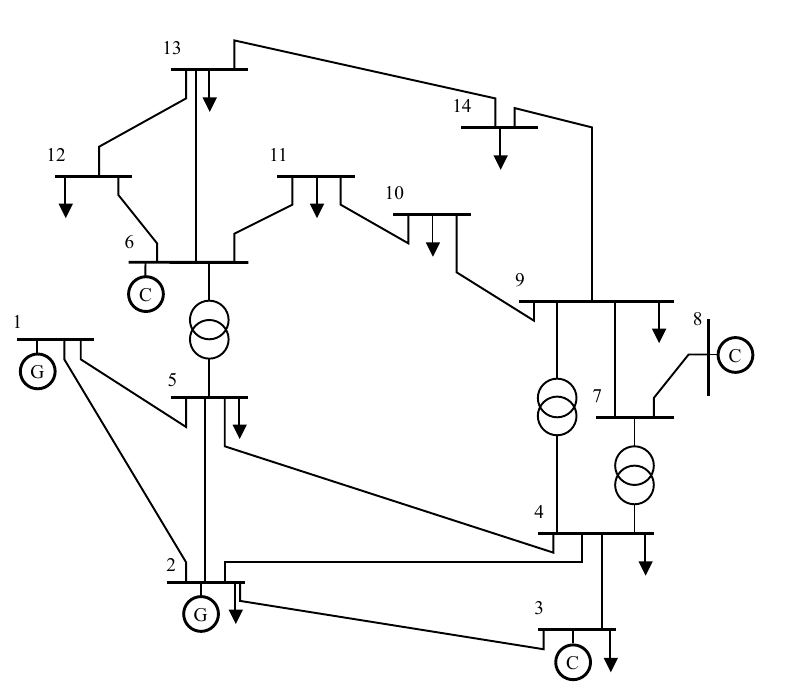
Figure 9. Single-line diagram of the IEEE-14 bus network.